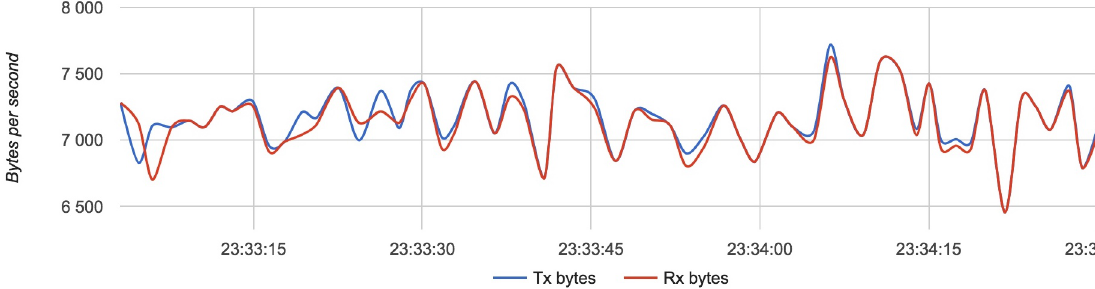
Figure 18. Bandwidth usage for a router with Configuration